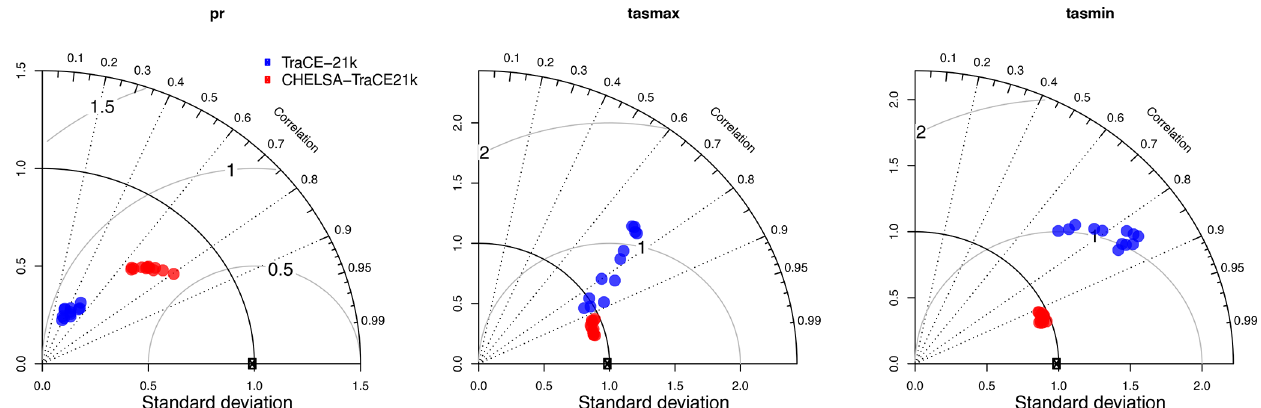
Figure 3. Taylor diagrams comparing the relationship between TraCE-21k (blue) and CHELSA-TraCE21k (red). Data are shown for the 20th-century time period with average monthly observational data from the Global Historical Climate Network (GHCN) for the time period 1950–1990. Each dot represents a specific